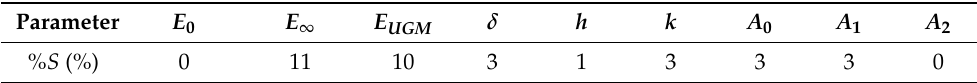
Table 2 regroups the values of relative surface variation obtained after applying a ± 10% variation for each parameter of the Huet–Sayegh model. Table 2. Relative surface variation % S calculated after a ± 10% variation for each parameter of the Huet–Sayegh